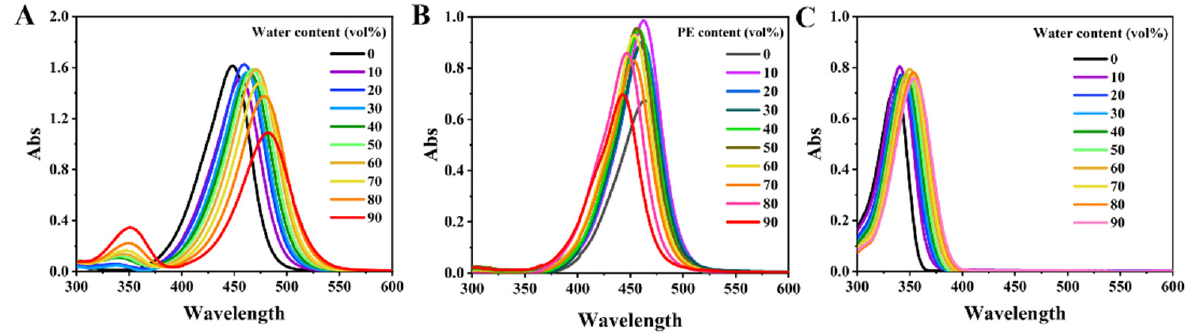
Figure 1. UV-vis spectra of ( A ) BNEA in THF-H 2 O mixture solution, ( B ) BNEA in DCM-PE mixture solution ([BNEA] = 20 µ M) and ( C ) M4 in THF-H 2 O mixture solution ([M4] = 20 µ M).